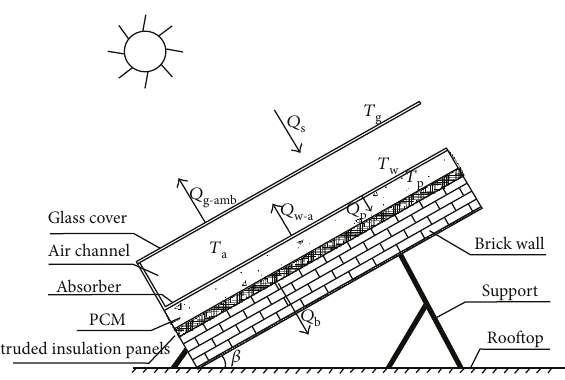
Figure 1: Schematic diagram of the PCM-based solar chimney during daytime.